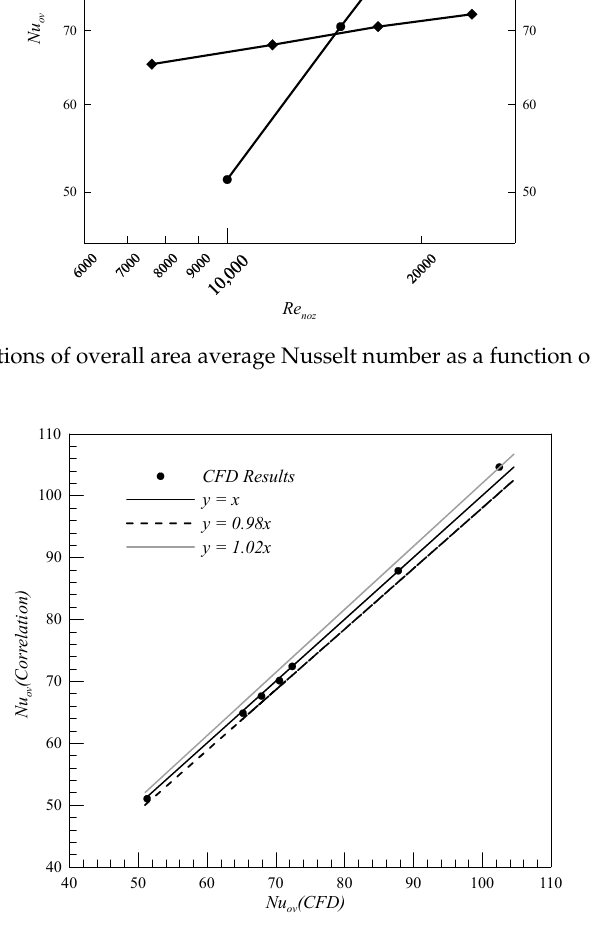
Figure 23. Overall Nusselt number correlation fit with CFD and computation results.